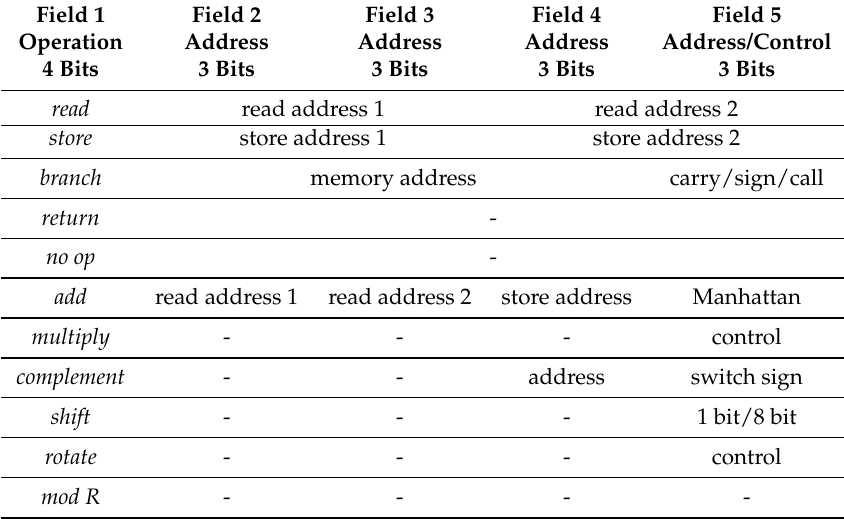
Table 3. Definition of the instruction